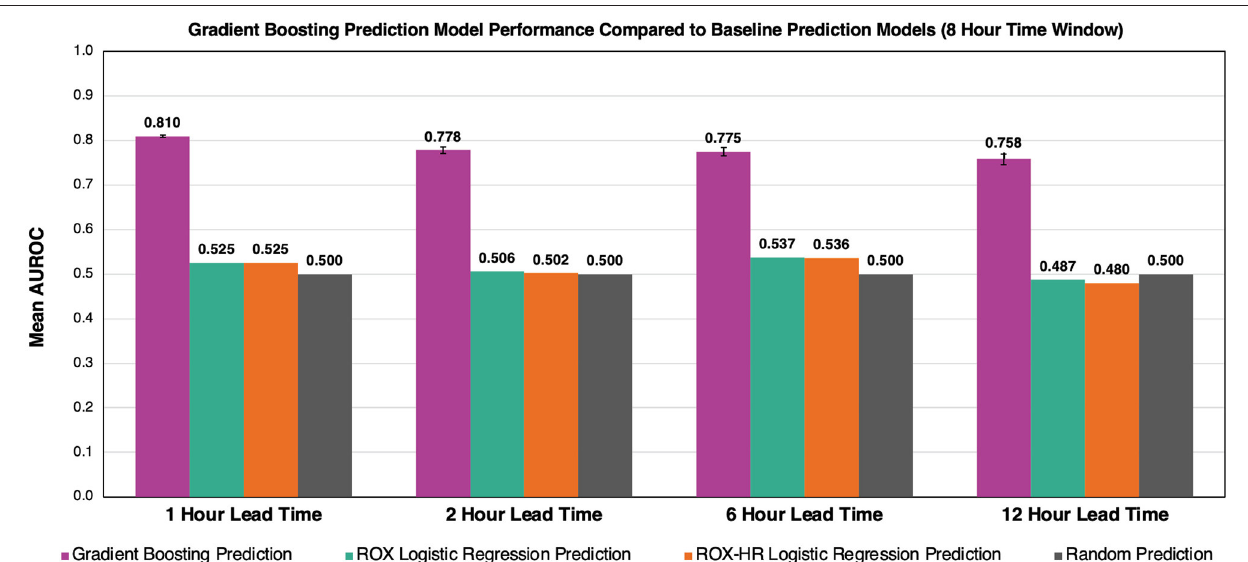
Frontiers in Pediatrics |